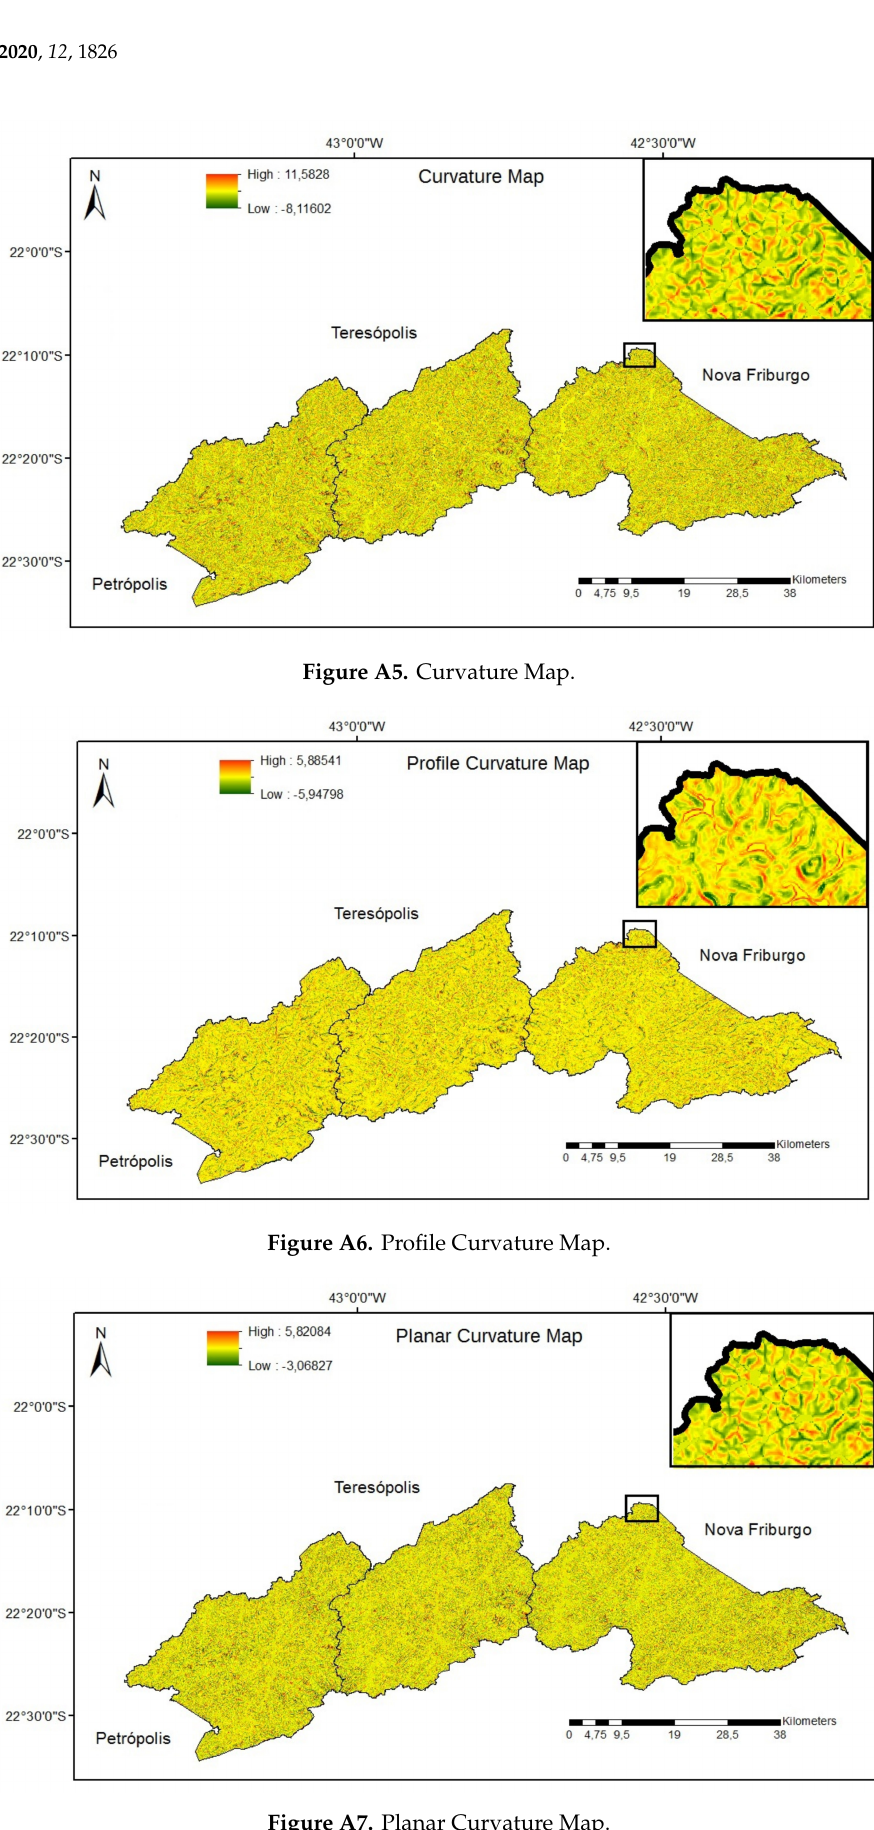
Figure A7. Planar Curvature